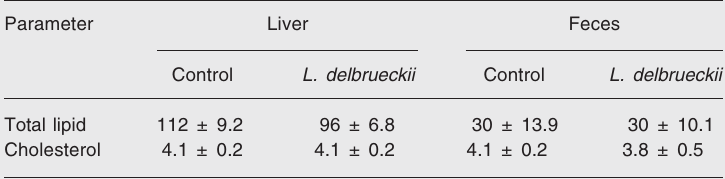
Data are reported as mean ± SEM in mg/g. The controls received vehicle. There were no statistical differences between control and L. delbrueckii -treated mice (Student t -